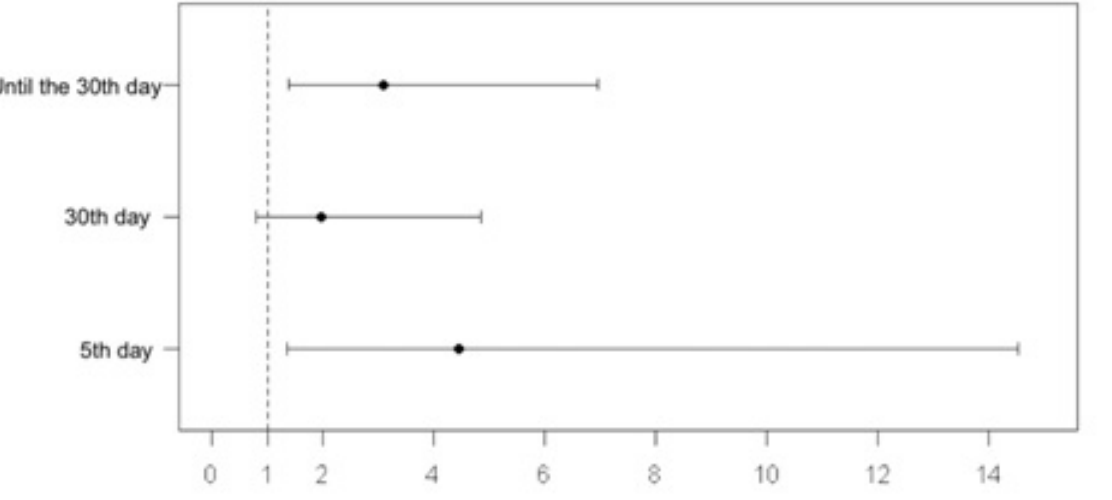
Fig. 2 – Odds ratio of patients with and without mapping on the 5 th and 30 th postoperative days and total up to the 30 th day.